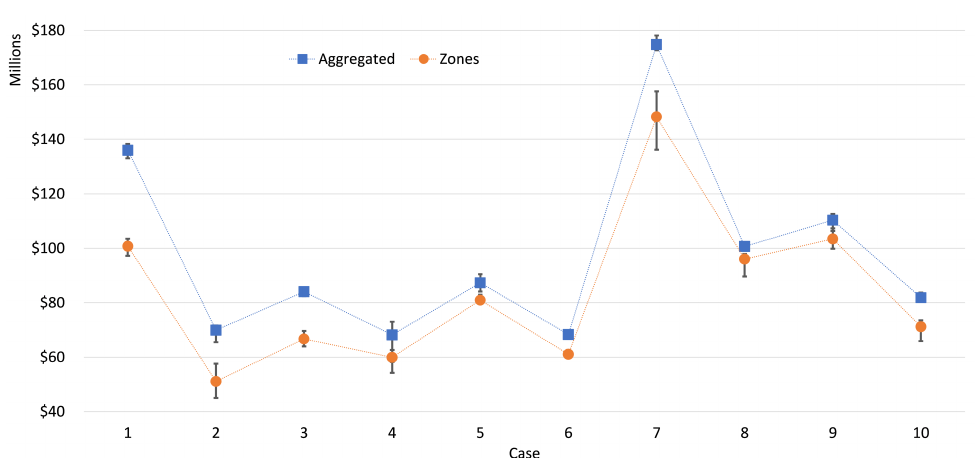
Figure 15. Average thermal generation costs over the five trials. The error bars indicate the minimum and maximum costs of each